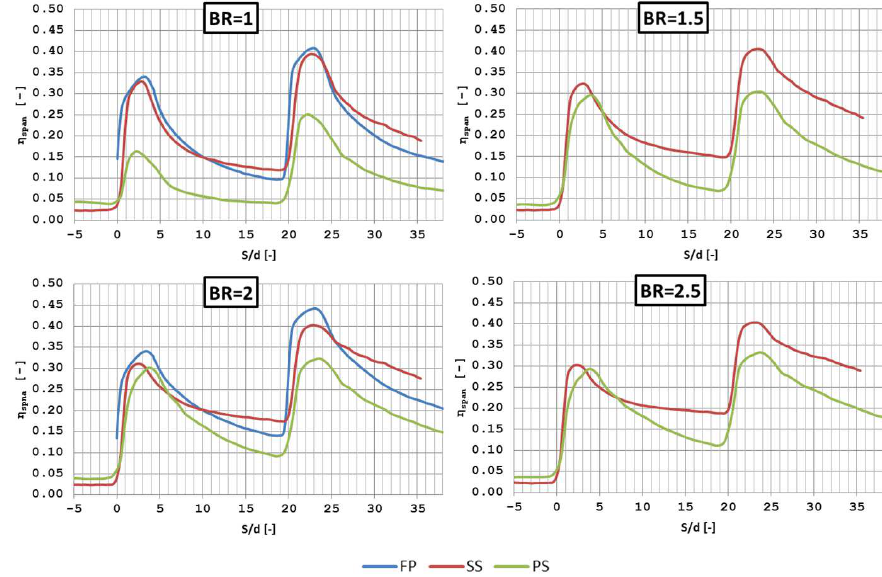
Figure 7. Spanwise average effectiveness 1D profile: comparison between investigated